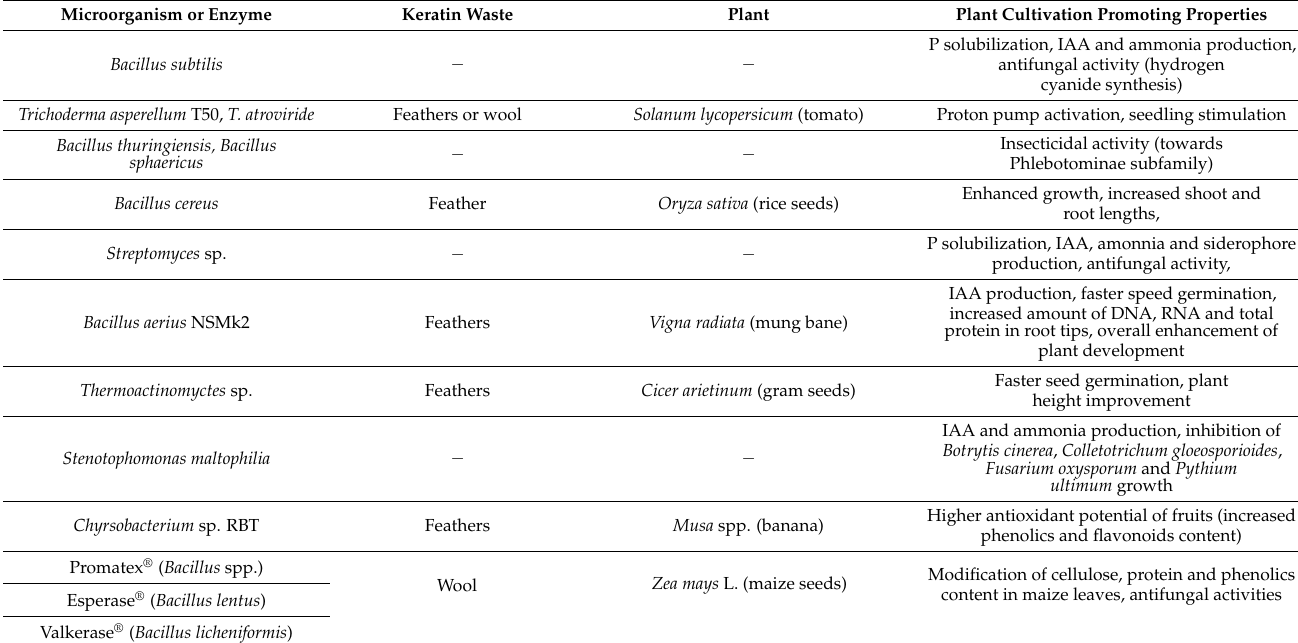
P solubilization, IAA and ammonia production, antifungal activity (hydrogen cyanide synthesis) Phlebotominae subfamily) root lengths, IAA production, faster speed germination, increased amount of DNA, RNA and total protein in root tips, overall enhancement of plant development